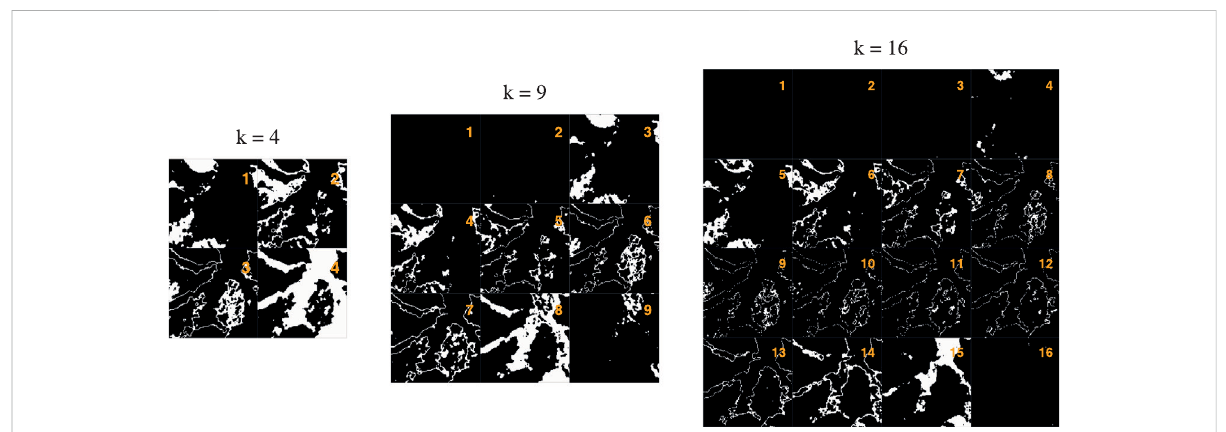
FIGURE 7 Example of binary masks obtained by the k-textures model for k = 4, 9 and 16 classes for a patch of 128 × 128 pixels extracted from the planet 4,096 × 4,096 pixels image. For k = 9 and k = 16,the patch does not contain all theclusters, it isnot mandatory for apatch to contain all